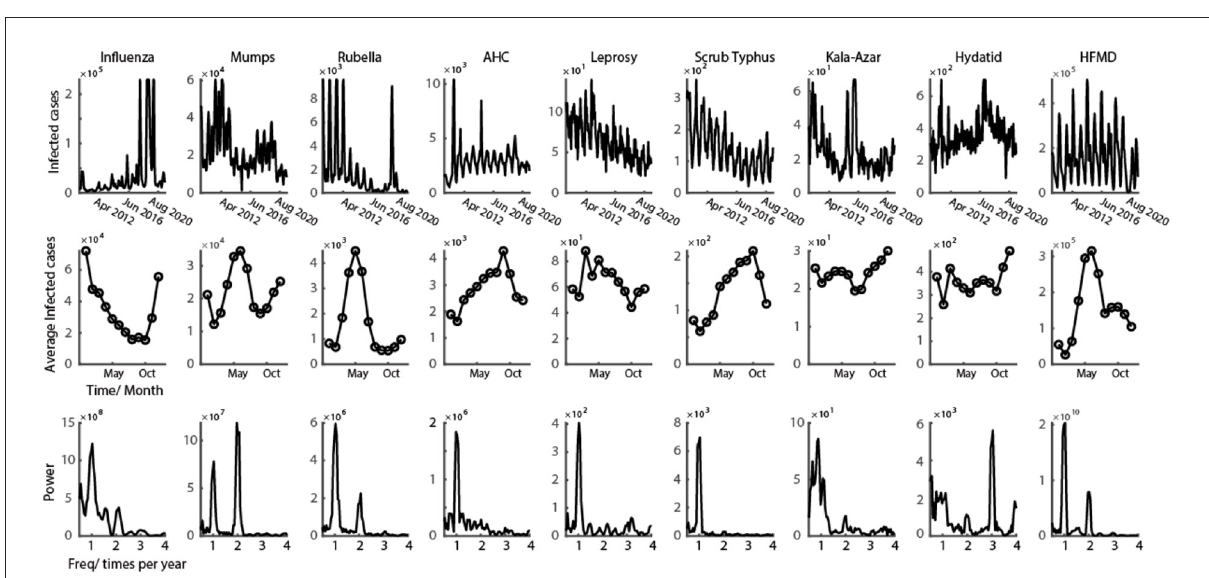
FIGURE1 Representative class C infectious disease with clear oscillation pattern. First row shows the time series of monthly infected cases from 2009 to 2021 for nine class C infectious diseases. Second row shows the average number of infected cases every month in a year. Third row illustrates the power spectrum calculated from the data of first row (data in the figure could be found in Supplementary